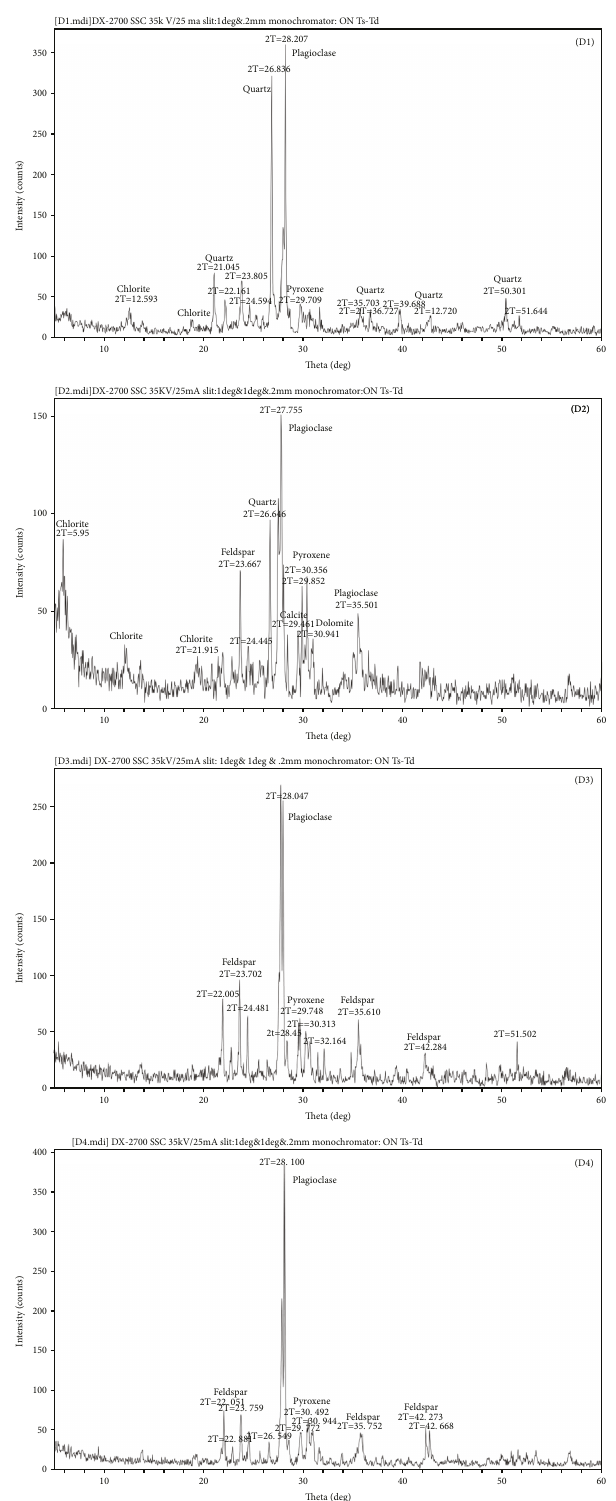
Figure 9: Diagram of X-ray di ff raction of rock